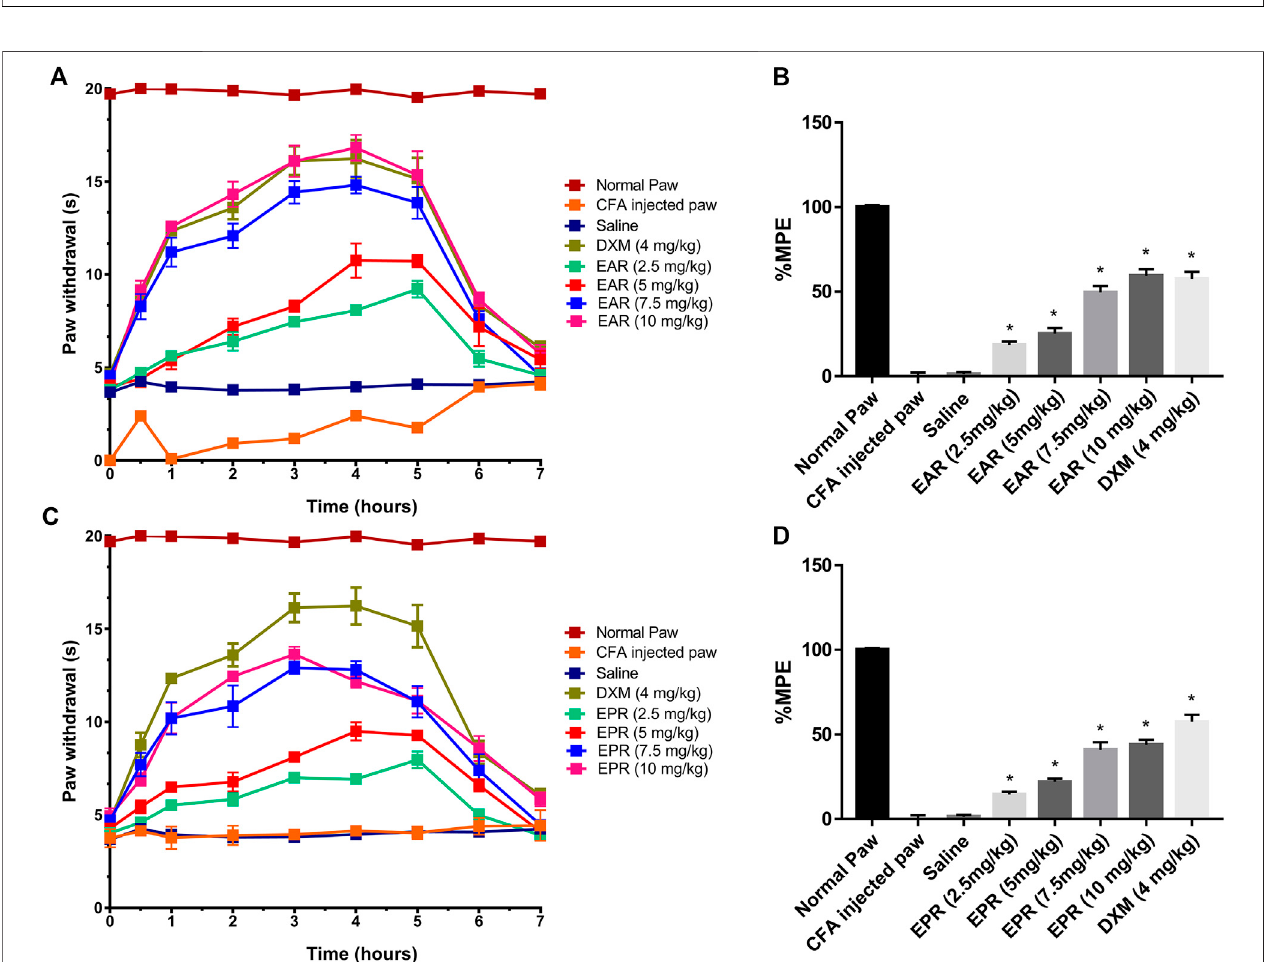
FIGURE5| Timecourseofpawwithdrawalresponses (A,C) observedafteracuteoraladministrationof E.angustifolia rootextract(EAR)or E.purpurea rootextract (EPR) anddexamethasoneinperipheralpain inratsand corresponding areaunderthecurve(AUC)foreachtreatmentexpressed aspercent ofmaximum possibleeffect (%MPE) (B, D) . The Normal Paw group is placed as a reference of the maximum possible effect. Saline solution was used as vehicle control for Complete Freund ’ s Adjuvant(CFA).Inallcases,dataarepresentedasmean ± SEMfor6rats.Signi fi cantdifferencesweredeterminedbyANOVAanalysisand posthoc Dunnett ’ st-test relative to saline vehicle (* p <